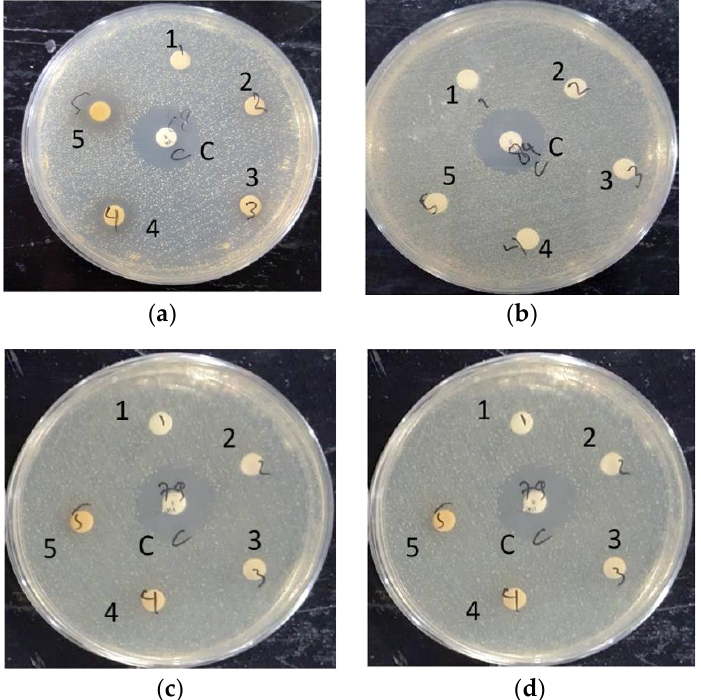
Figure 3. Documented run for: ( a ) ethanol-based S. caseolaris leaves extract; ( b ) water-based A. marina leaves extract; ( c ) water-based R. mucronata leaves extract; ( d ) water-based R. apiculata leaves extract on LB agar medium grown with MRSA strain. The middle disk labeled C is positive control Vancomycin, while the numbered labels were concentrations of diluted extracts. Label number 1 is the smallest extract concentration at 1250 ppm, number 2 is 2500 ppm, number 3 is 5000 ppm, number 4 is 10000 ppm, and number 5 is the largest concentration at 20,000 ppm.